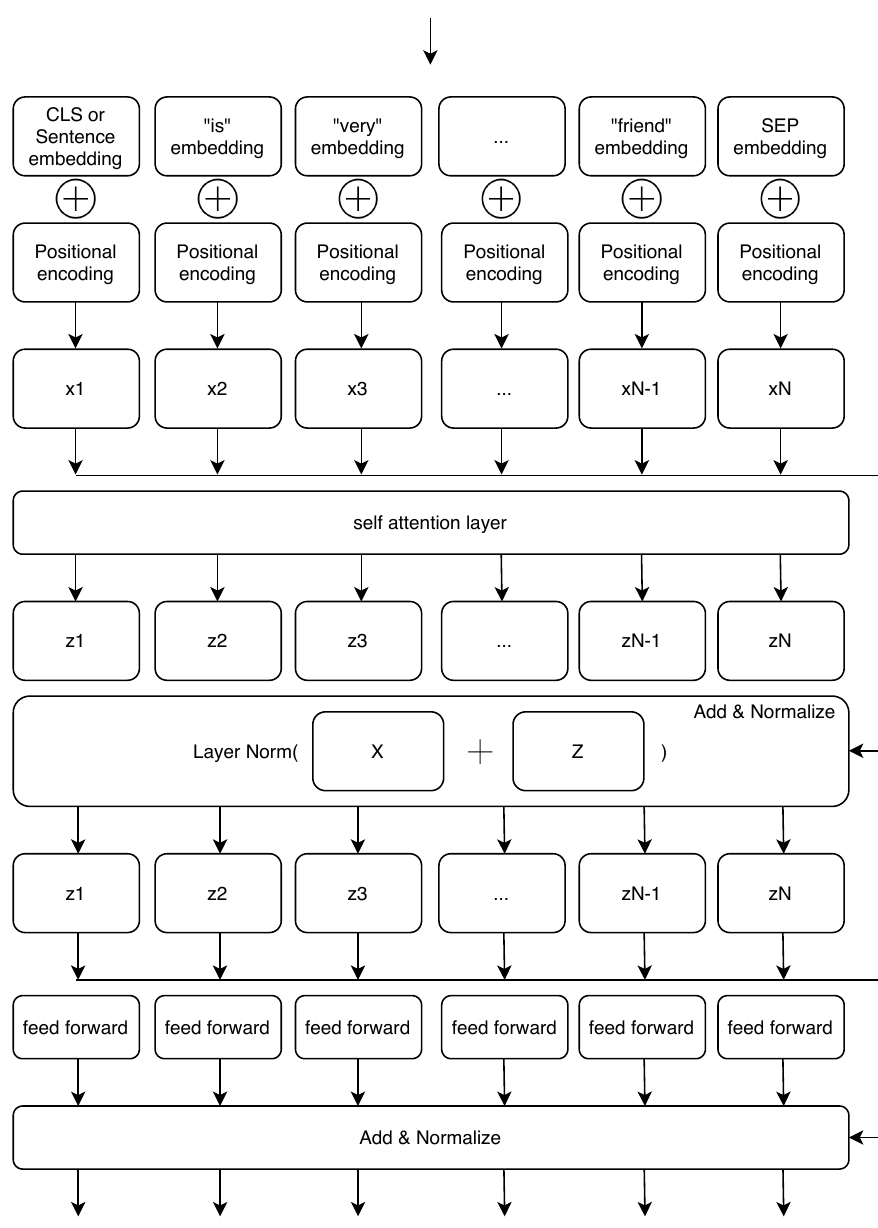
Figure 3. This is a representation of one encoding layer mentioned in Figure 4. There are twelve of this encoding layer in the final architecture. The word embedding of each token passes through these encoding layers and at the end we obtain the transformed word